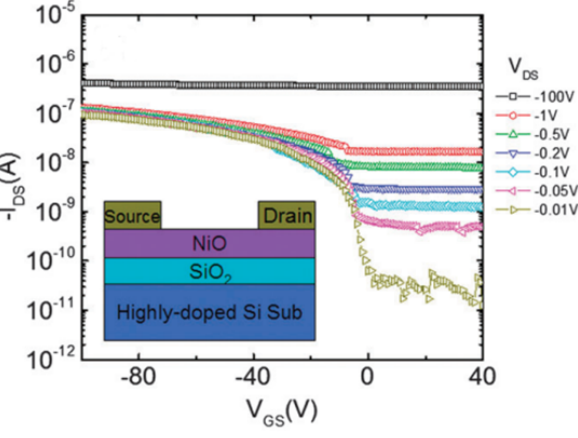
Figure 14: Transfer characteristics of p-type NiO TFT [82]